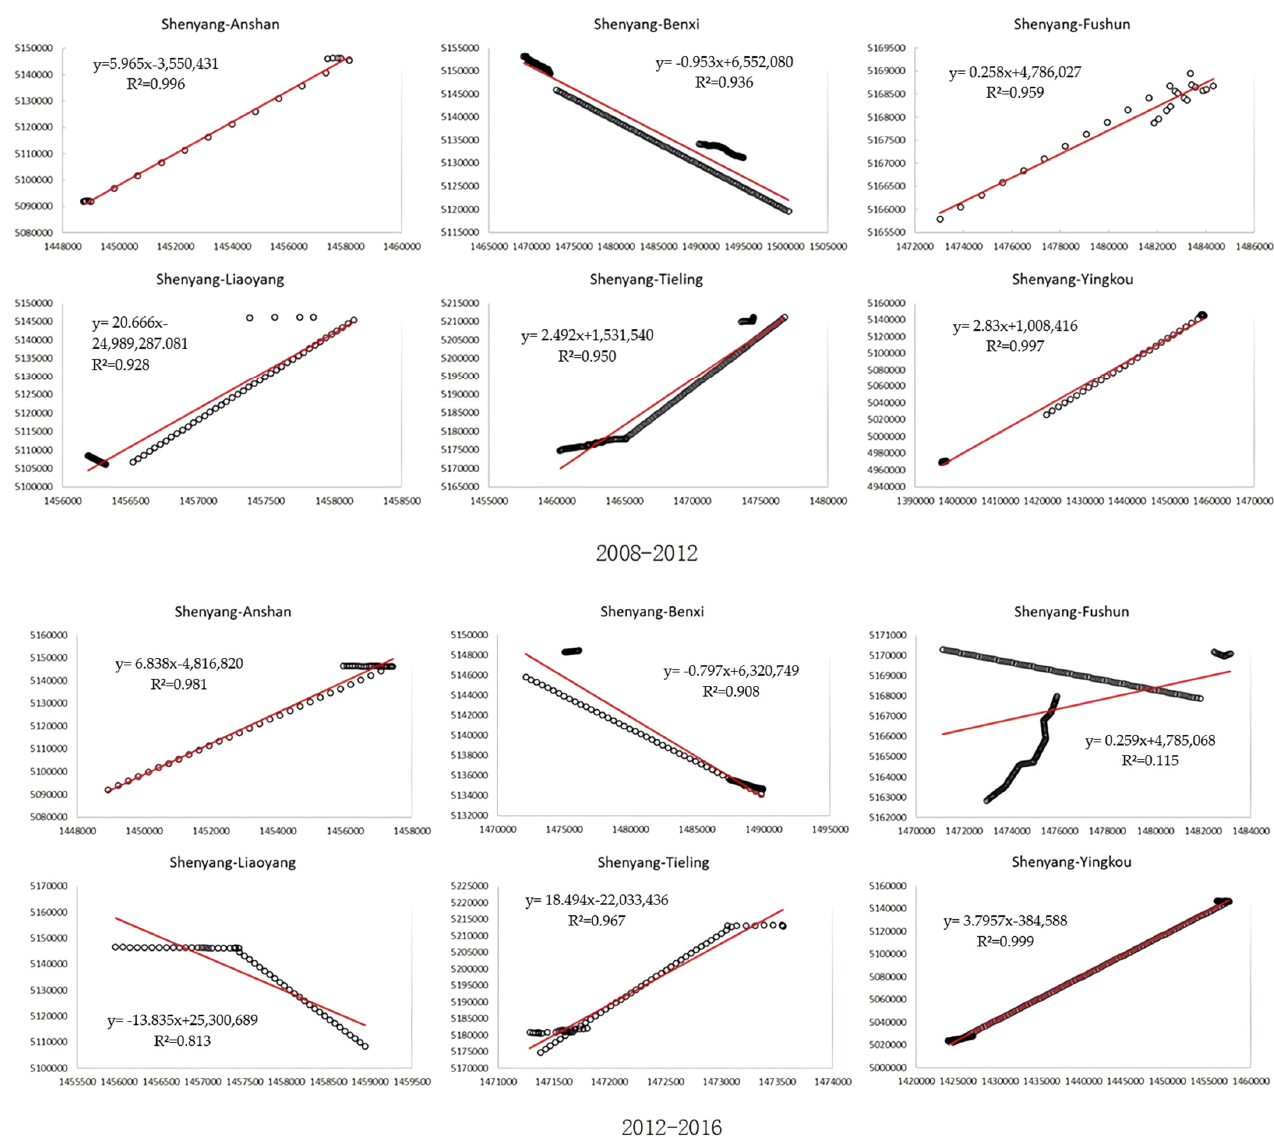
Figure 10. The correlation analysis results of urban gravitational trajectory and urban gravitational direction